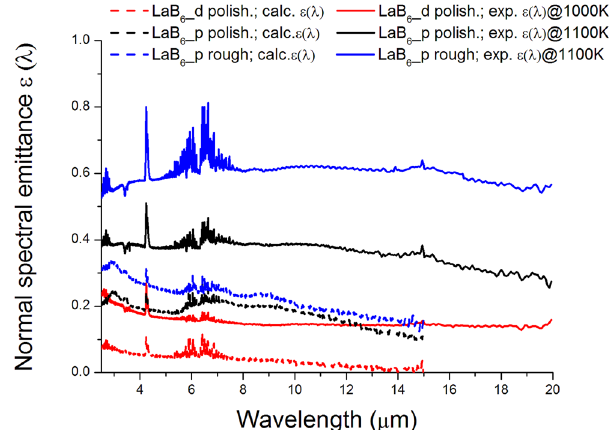
Figure 5. Calculated (dashed lines) and experimental emittance (solid lines) of LaB 6 samples. The measurement temperature for each sample is indicated in legend. The features at around 3.4 µ m, 4.2 µ m, between 4.8 and 7.7 µ m and around 15 µ m are instrumental artifacts due to unbalanced molecular absorption by ambient air in the optical path of the beams outside the